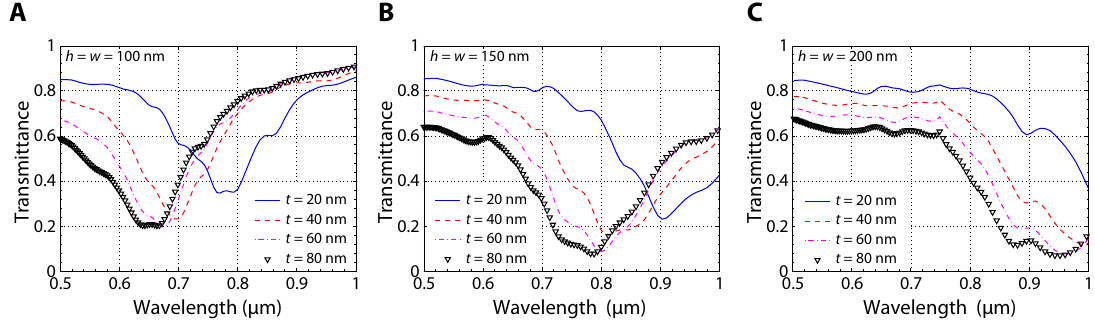
Figure 10: Simulated resonance curves of single gold bow-tie antennas on a fused silica substrate. With fixed values for gap size g = 25nm and tip rounding radius r tip = 10nm , the results from several configurations of h = w and t are shown ( a , h = w = 100nm , b , h = w = 150nm , c , h = w = 200nm ). With varying t , only the blue curve ( t = 20nm ) in a and, more prominently, the black, magenta and red curves ( t = 80, 60, 40nm ) in b seem to be suitable for resonance at 800nm (Simulation courtesy of J. Petschulat).